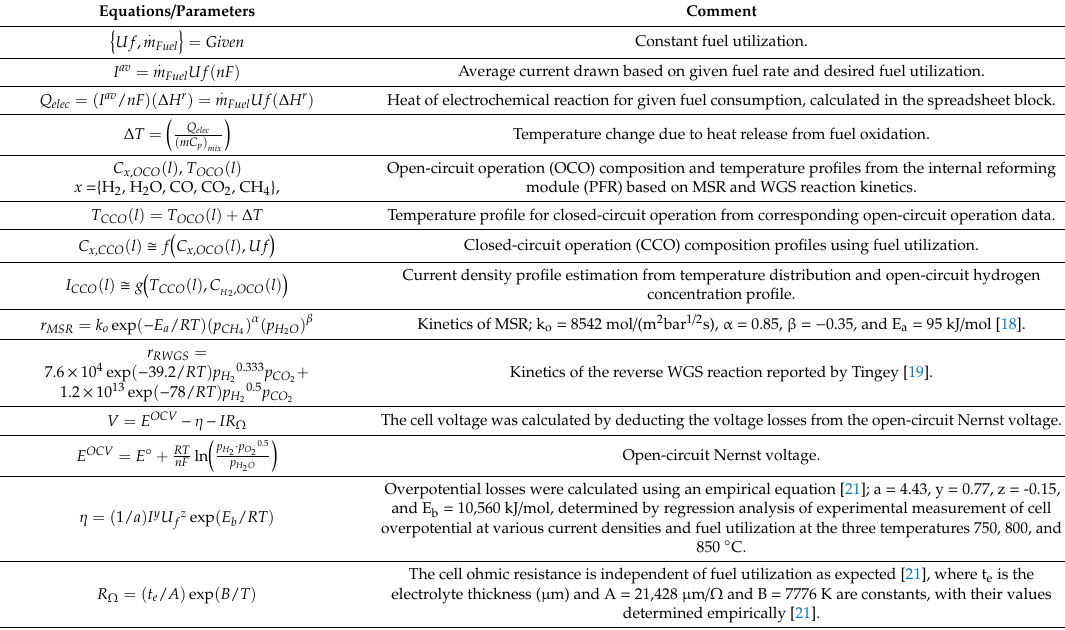
Table 1. Modeling approach for solid oxide fuel cell (SOFC) performance approximation. Equations / Parameters